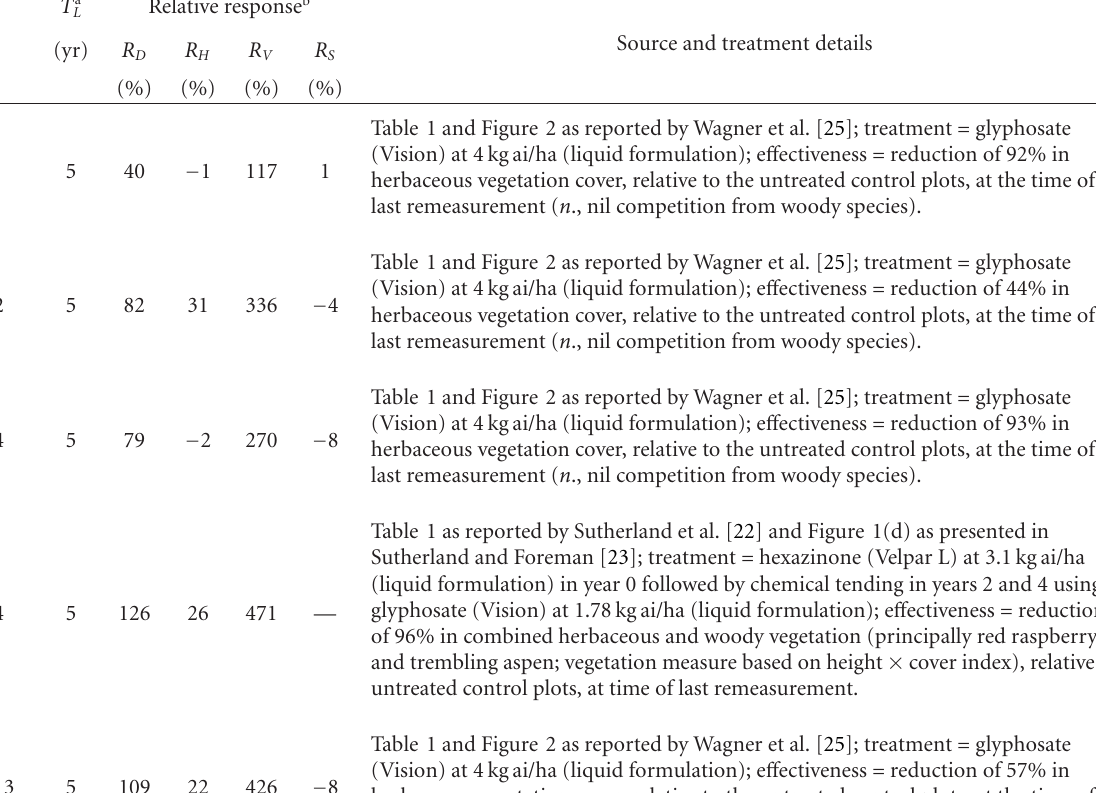
Table 1 and Figure 2 as reported by Wagner et al. [25]; treatment = glyphosate (Vision) at 4 kgai/ha (liquid formulation); e ff ectiveness = reduction of 92% in herbaceous vegetation cover, relative to the untreated control plots, at the time of last remeasurement ( n ., nil competition from woody species). Table 1 and Figure 2 as reported by Wagner et al. [25]; treatment = glyphosate (Vision) at 4 kgai/ha (liquid formulation); e ff ectiveness = reduction of 44% in herbaceous vegetation cover, relative to the untreated control plots, at the time of last remeasurement ( n ., nil competition from woody species). Table 1 and Figure 2 as reported by Wagner et al. [25]; treatment = glyphosate (Vision) at 4 kgai/ha (liquid formulation); e ff ectiveness = reduction of 93% in herbaceous vegetation cover, relative to the untreated control plots, at the time of last remeasurement ( n ., nil competition from woody species). Table 1 as reported by Sutherland et al. [22] and Figure 1(d) as presented in Sutherland and Foreman [23]; treatment = hexazinone (Velpar L) at 3.1 kgai/ha (liquid formulation) in year 0 followed by chemical tending in years 2 and 4 using glyphosate (Vision) at 1.78kg ai/ha (liquid formulation); e ff ectiveness = reduction — of 96% in combined herbaceous and woody vegetation (principally red raspberry and trembling aspen; vegetation measure based on height × cover index), relative to untreated control plots, at time of last remeasurement. Table 1 and Figure 2 as reported by Wagner et al. [25]; treatment = glyphosate (Vision) at 4 kgai/ha (liquid formulation); e ff ectiveness = reduction of 57% in herbaceous vegetation cover, relative to the untreated control plots, at the time of last remeasurement ( n ., nil competition from woody species). Table 1 and Figure 2 as reported by Wagner et al. [25]; treatment = glyphosate (Vision) at 4 kgai/ha (liquid formulation); e ff ectiveness = reduction of 94% in herbaceous vegetation cover, relative to the untreated control plots, at the time of last remeasurement ( n ., nil competition from woody species). Figures 13, 14, 15, and 16 as reported by Robinson et al. [28]; results for the scarified but unfertilized plots only; treatment = glyphosate (Vision) at 2kg ai/ha (liquid formulation); e ff ectiveness = approximate reduction of 100% in herbaceous and woody vegetation cover, relative to the untreated control plots, 3 years post-planting. Tables 2 and 3 as reported by Wood and von Althen [21]; mean responses based on bareroot and container stock-types results combined; treatment = annual application of glyphosate (Roundup) at 2kgai/ha (liquid formulation); e ff ectiveness = reductions of 90% and 100% in herbaceous and woody vegetation cover, respectively, relative to the untreated control plots, at time of last remeasurement. Table 1 and Figure 2 as reported by Wagner et al. [25]; treatment = glyphosate (Vision) at 4 kgai/ha (liquid formulation); e ff ectiveness = reduction of 96% in herbaceous vegetation cover, relative to the untreated control plots, at the time of last remeasurement ( n ., nil competition from woody species). Textual description and Figure 1 as reported in Pitt et al. [29] for Corrigal experimental site; annual directed foliar application of 1.58 or 2% liquid solution of glyphosate (Vision); e ff ectiveness: at the time of the 10yr remeasurement the average of all treatments had reduced the cover of deciduous woody tree species to less than 10%, tall shrub species to 8%, and low shrub species to